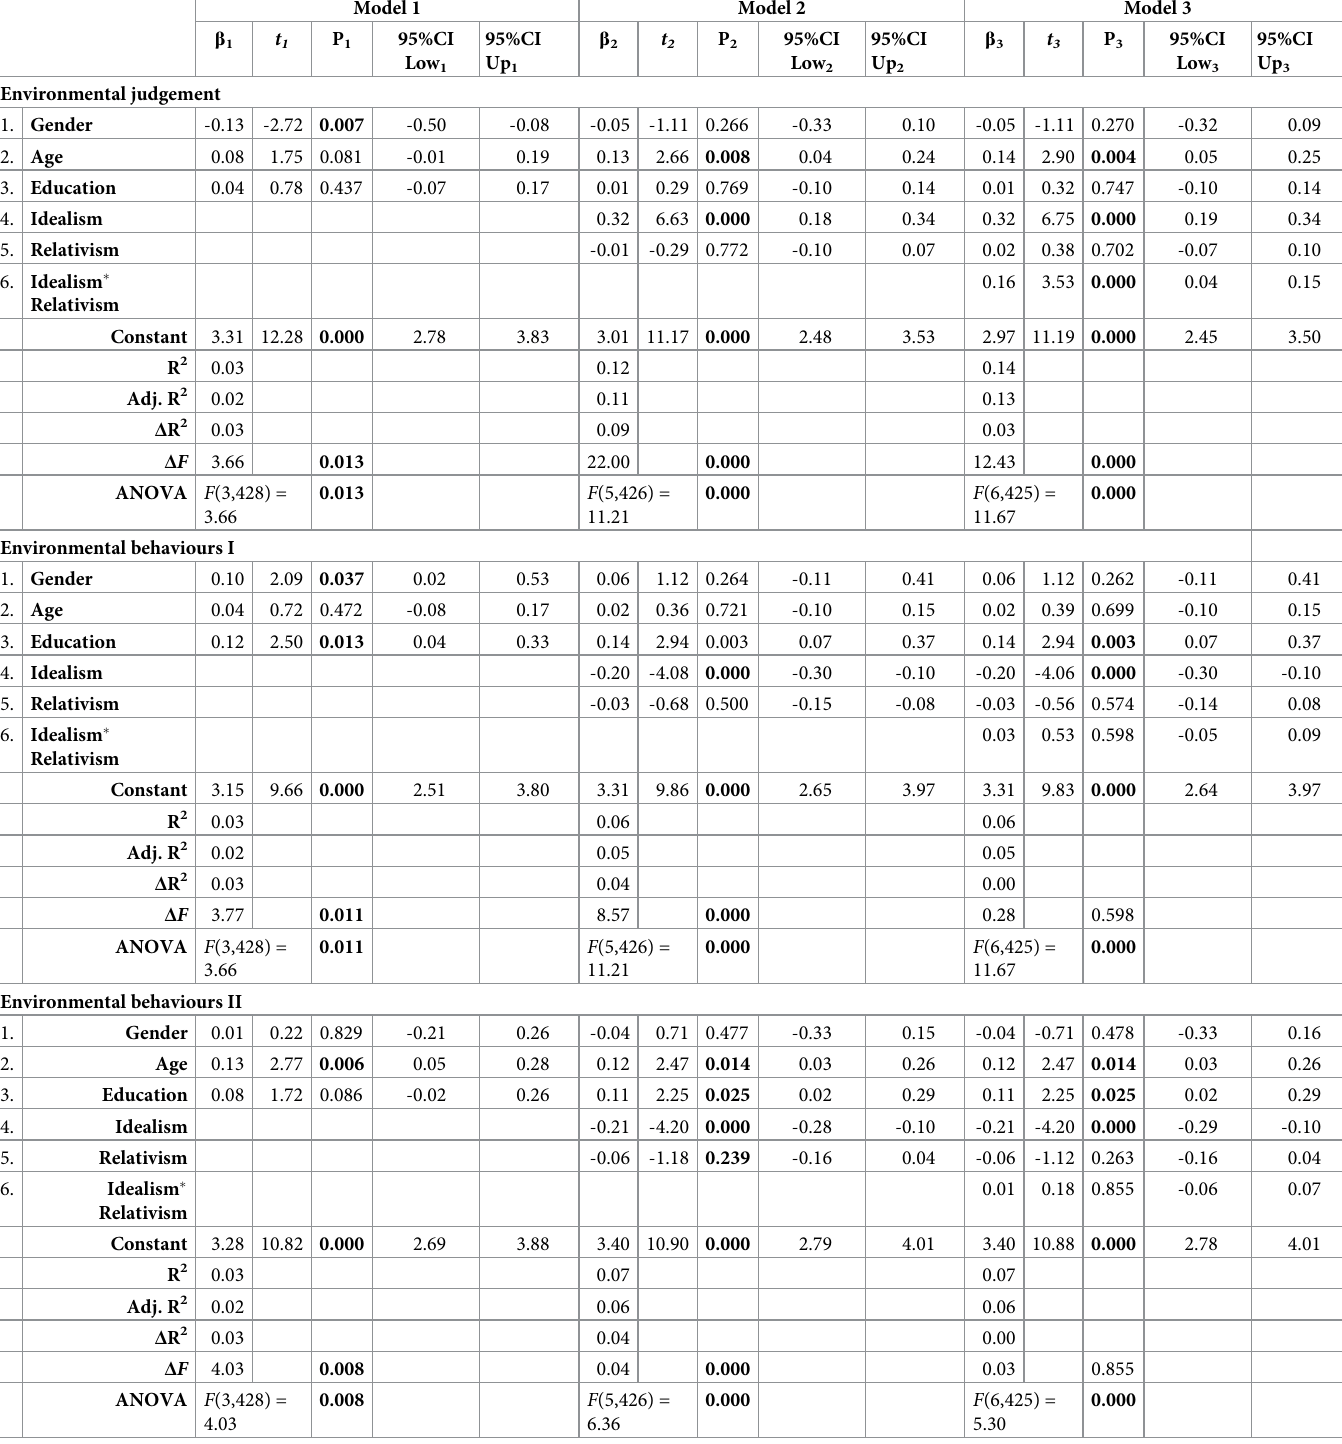
Table 7. Results of hierarchical multiple regression analyses predicting environmental judgement and environmental behaviours I &